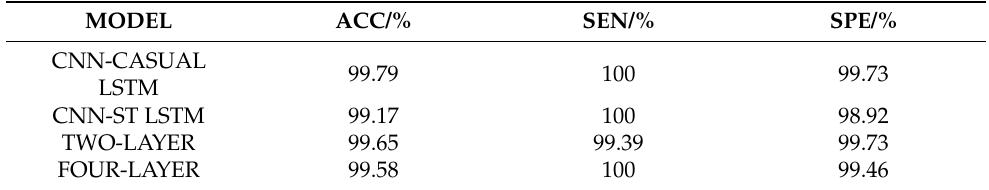
Table 1. Classification accuracy, sensitivity, and specificity of ablation experiments on the SisFall data set.